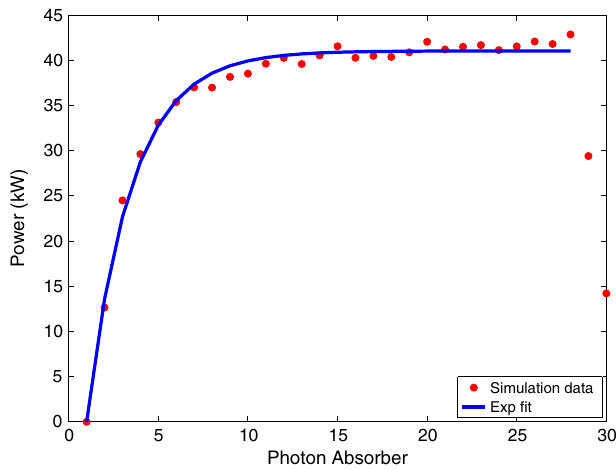
FIG. 7. Dimensions of the clearing electrode designed for cloud suppression in the wiggler magnets.